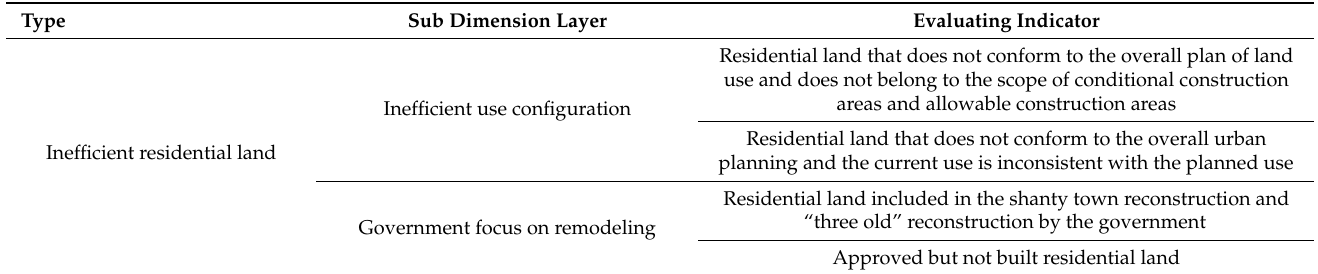
Table 2. Identification standards of inefficient residential